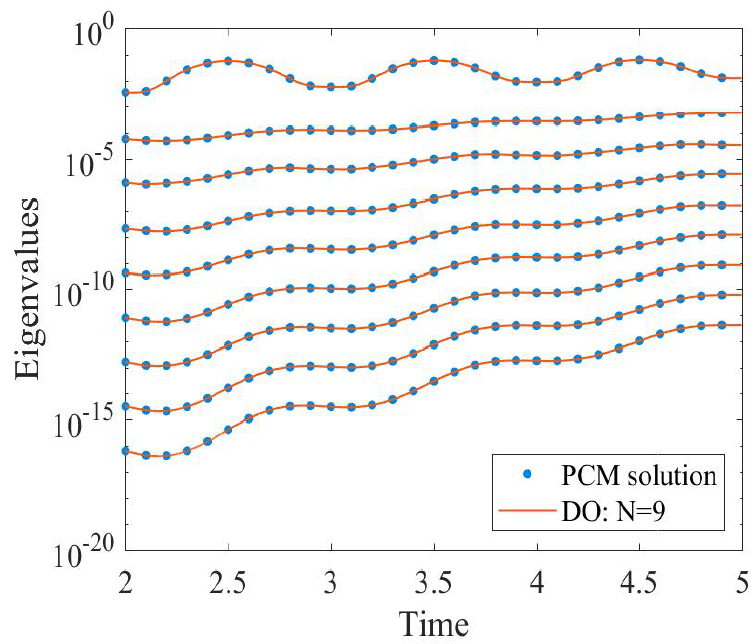
, switching , switching   =    =